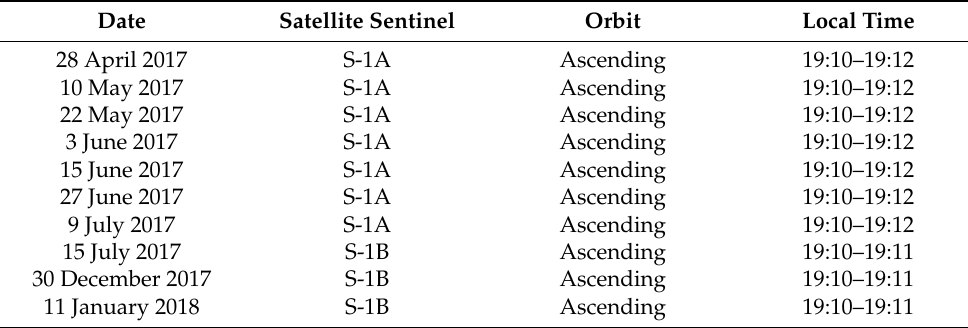
Table 1. The TopSAR images used in the present